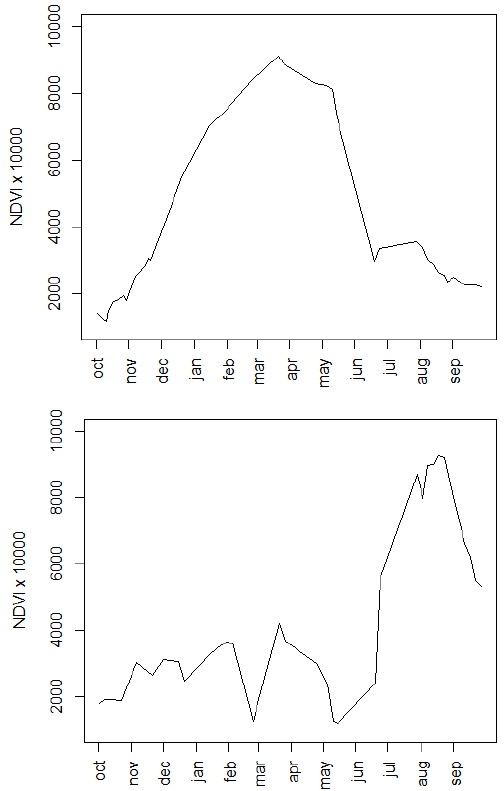
Figure 5. Examples of typical NDVI profiles observed for Autumn/Winter crops (top) and Spring/Summer crops (bottom).